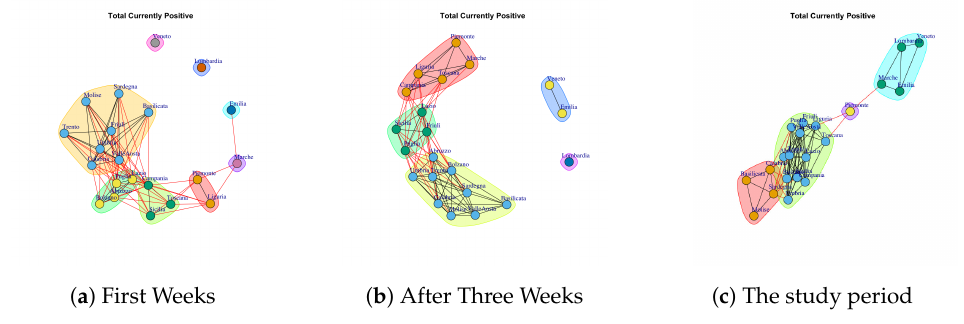
Figure 18. Evolution of Total Currently Positive Network Communities.